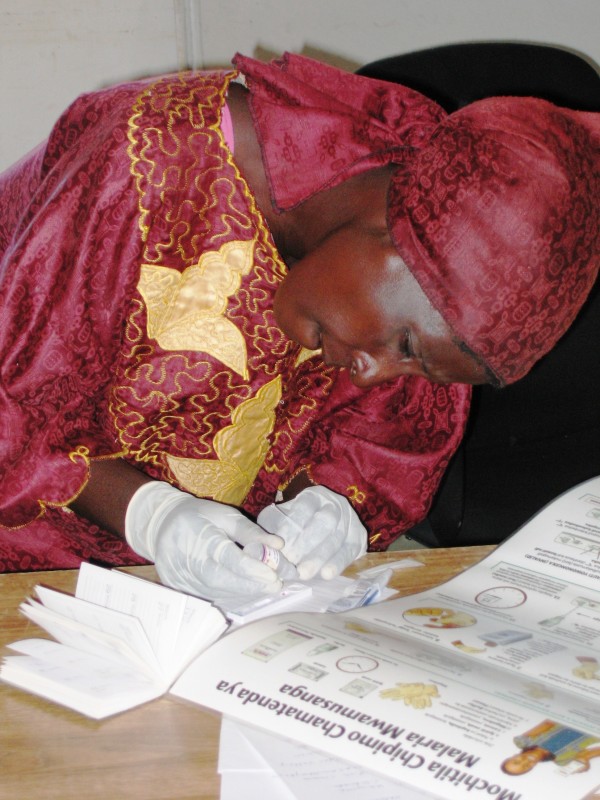
CHW training in RDT preparation. A Zambian CHW adds buffer to a malaria rapid diagnostic test during training on RDT use.